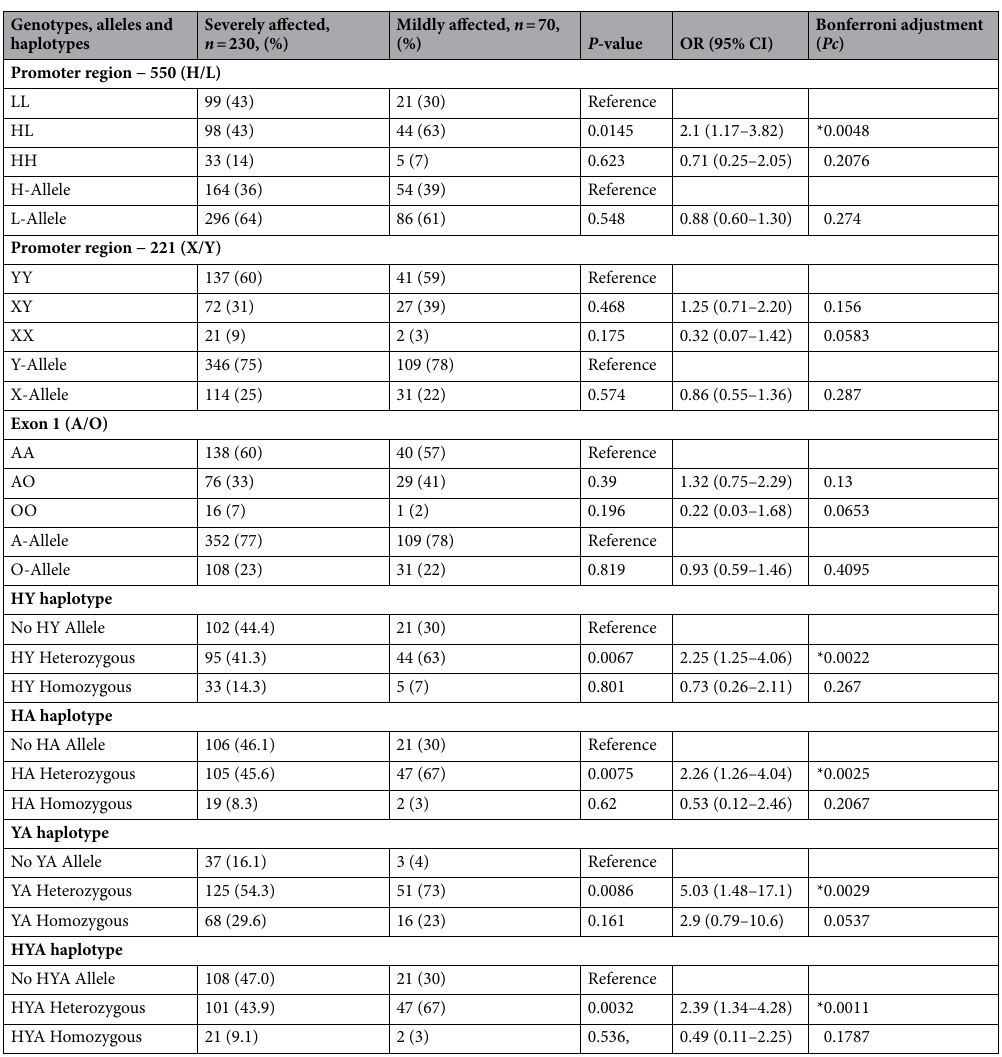
Table 3. Associations between MBL2 SNPs and GBS disease severity. SNPs single nucleotide polymorphisms, GBS Guillain Barré syndrome, P-value probability value, OR odds ratio, 95% CI 95% confidence interval. The Bonferroni-adjusted significance threshold was 0.0167 for genotypes and 0.025 for alleles, *statistically significant after P value